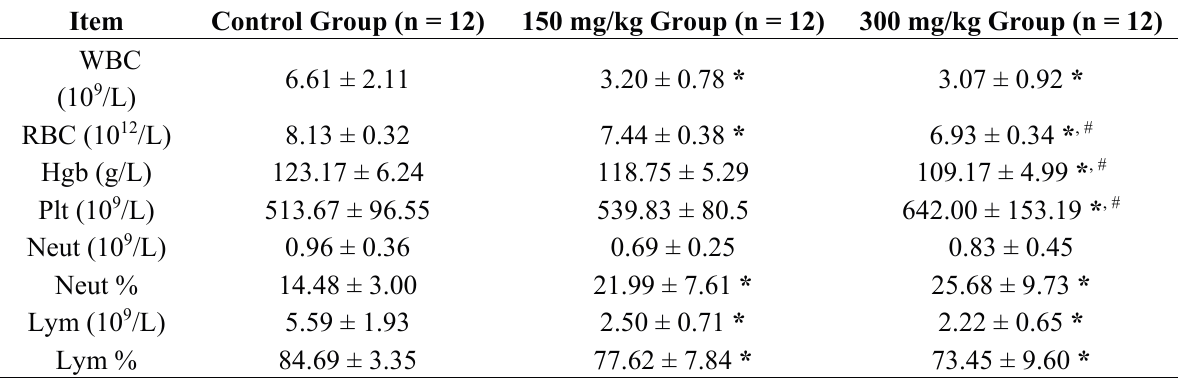
Table 2. Routine blood test results of the benzene exposure